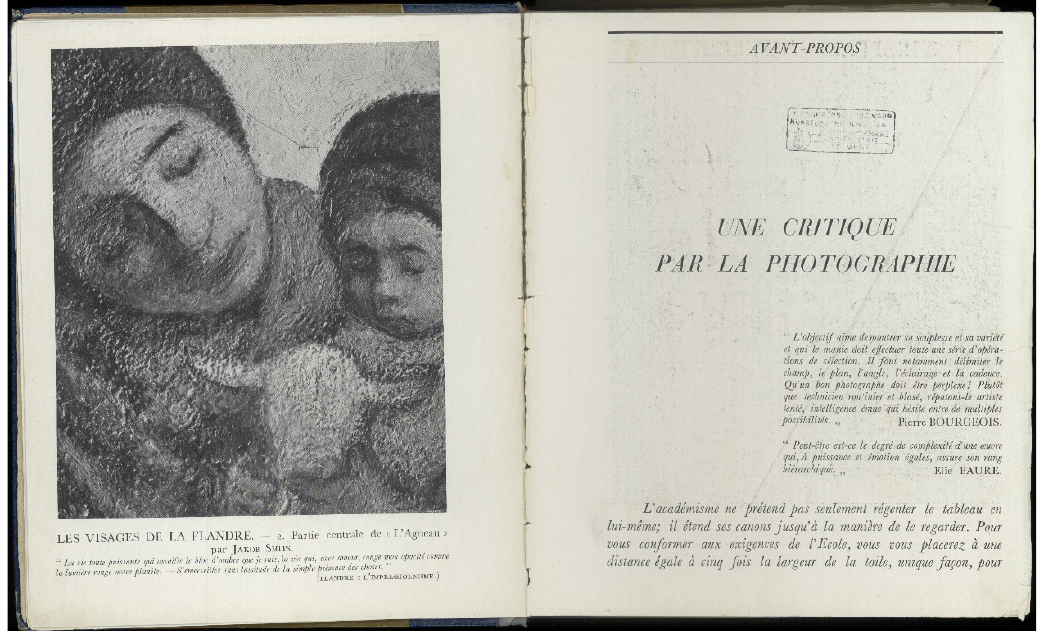
Figure 2. Luc and Paul Haesaerts, Flandre: Essai sur l’art flamand depuis 1880 . Paris: Éditions de chro- niques du jour G. di San Lazzaro, 1931. Ghent University Library, shelfmark LWBIB.L70.11.W.0022.